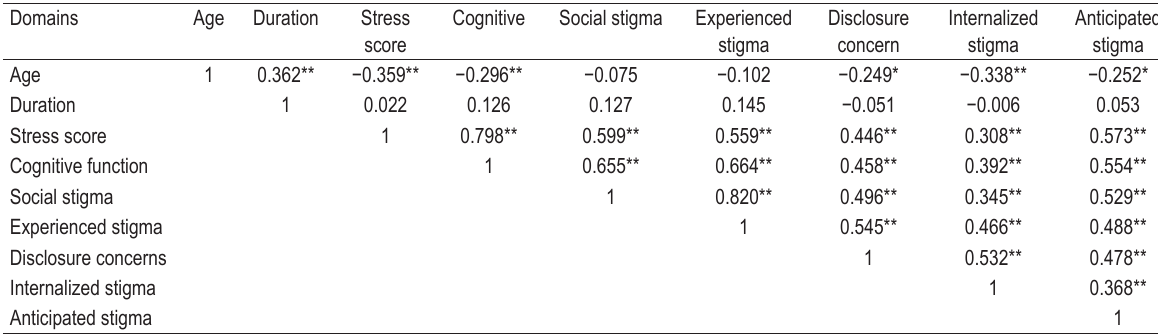
TABLE 3. Pearson correlation between the patients’ characteristics different domains